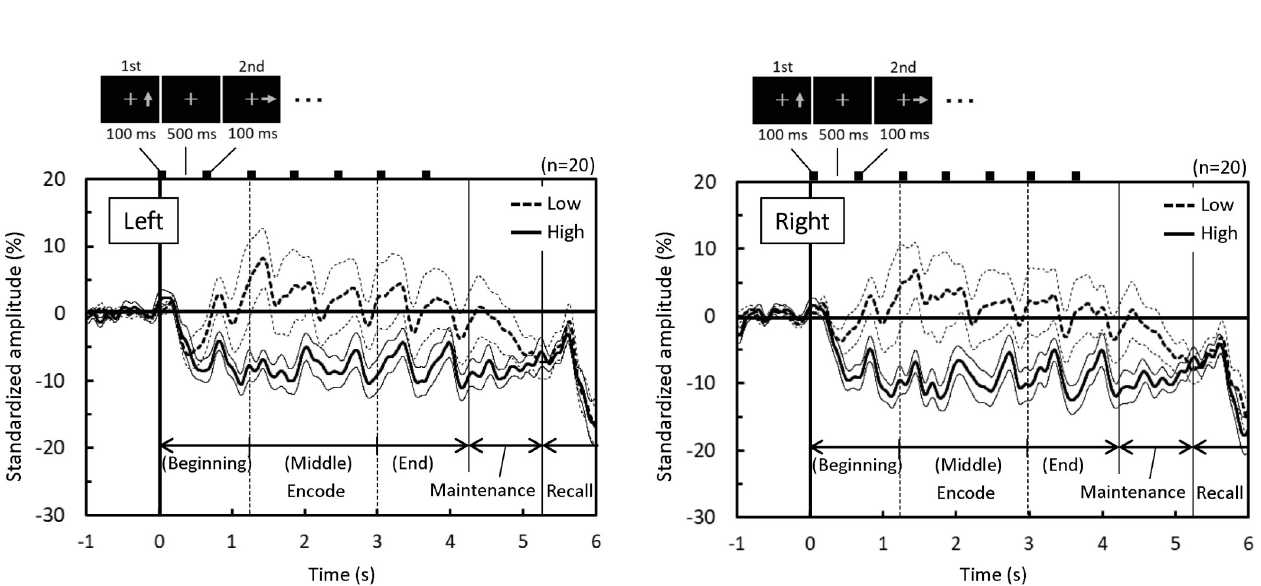
Fig 5. Time courses of standardized alpha-rhythm amplitude originating from the left and right PCu. Signals are expressed as a percent deviation from baseline (-1–0 s). Time courses of the mean values and standard errors across subjects are shown. Alpha-rhythm amplitude desynchronized markedly during encoding in the High group, but not in the Low group. Laterality (Left/Right) was not markedly different.